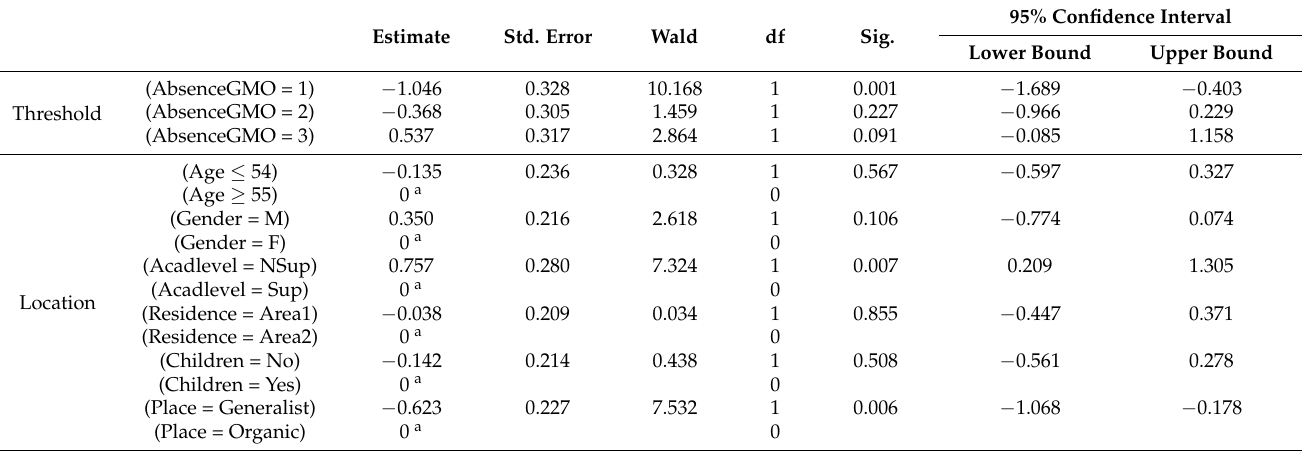
Table 8. Significance of the independent variables.